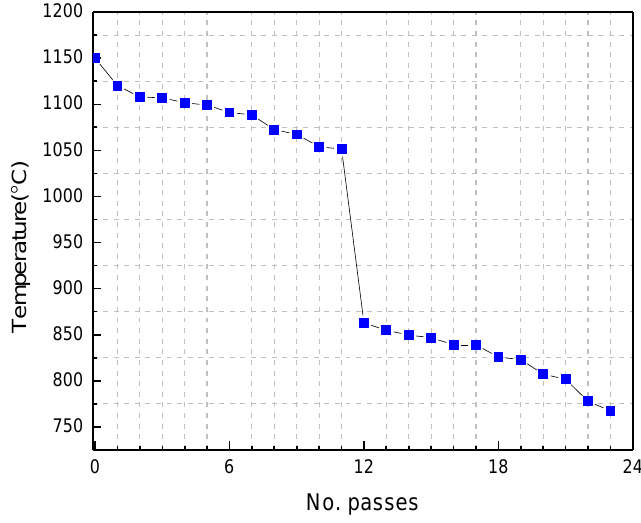
Figure 2. Temperature profile of a modern 5 m wide reversing plate mill, after reference [22].